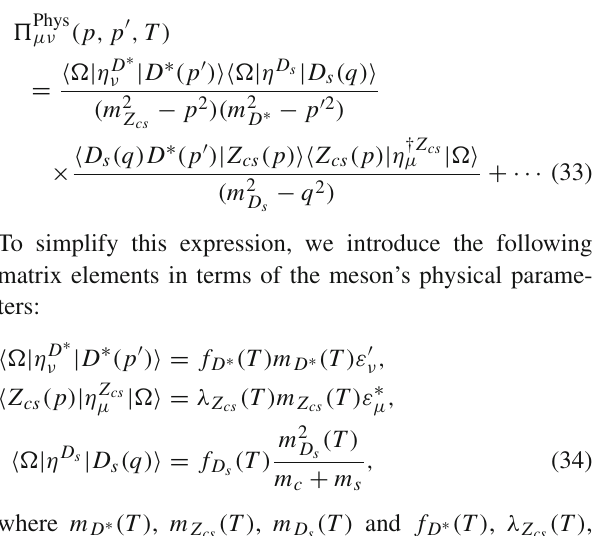
Fig. 3 Theratioofthetemperature-dependentmeson-currentcoupling constant to vacuum meson-current coupling constant of the Z cs state, respectively, in the tetraquark picture for fixed values of s 0 ( 0